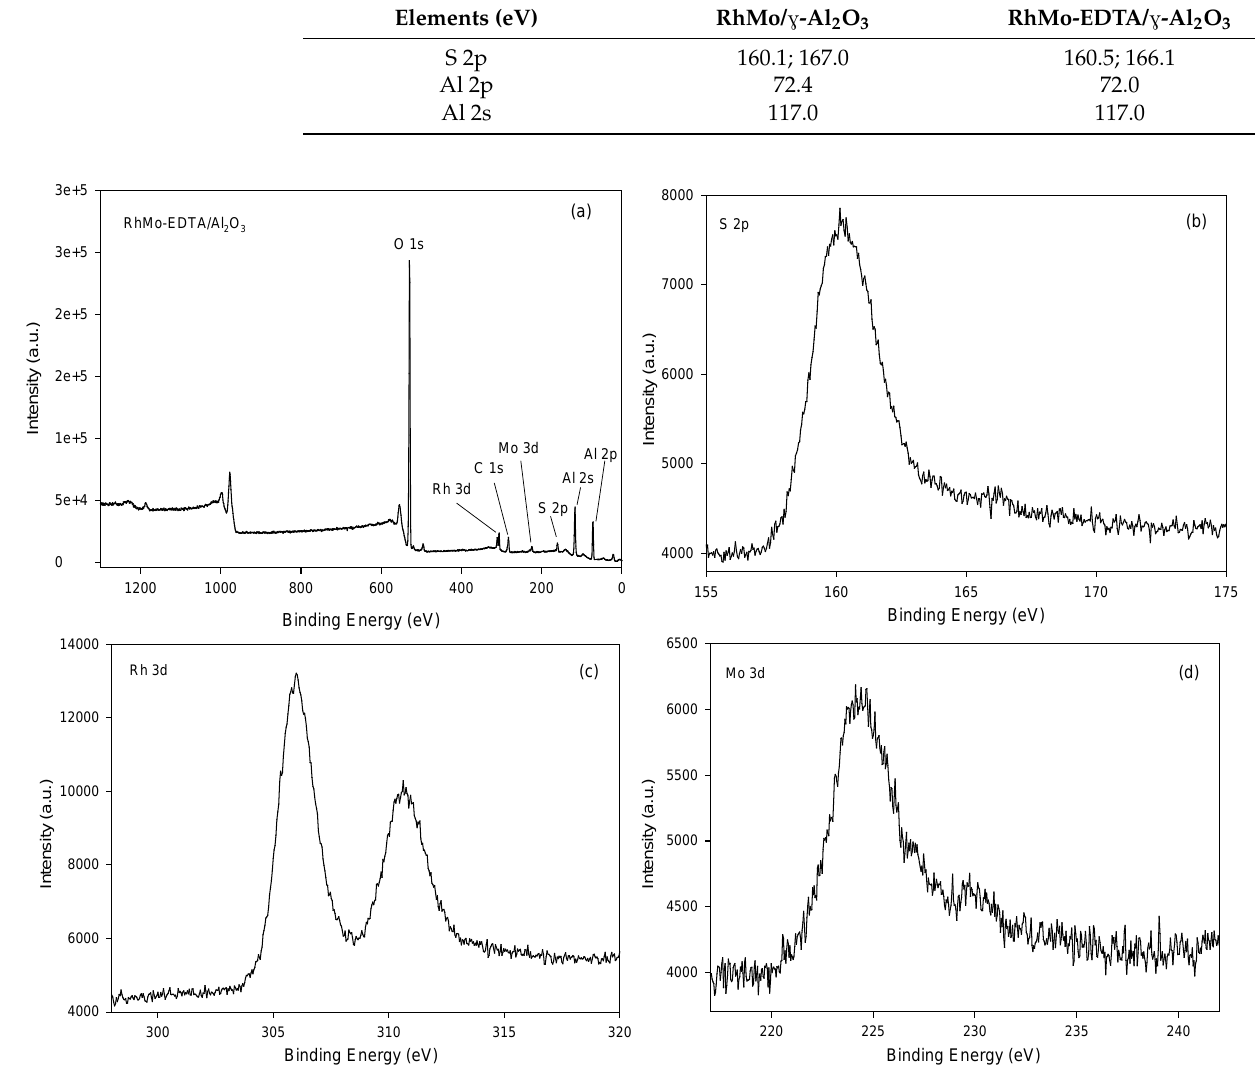
Figure 4. XPS spectra for ( a ) RhMo-EDTA/ ɣ -Al 2 O 3 survey spectrum with different elemental contributions, ( b ) S 2p, ( c ) Rh 3d, ( d ) Mo 3d. Table 3. Binding energies determined in XPS experiments for RhMo/Al 2 O 3 and RhMo-EDTA/ ɣ -